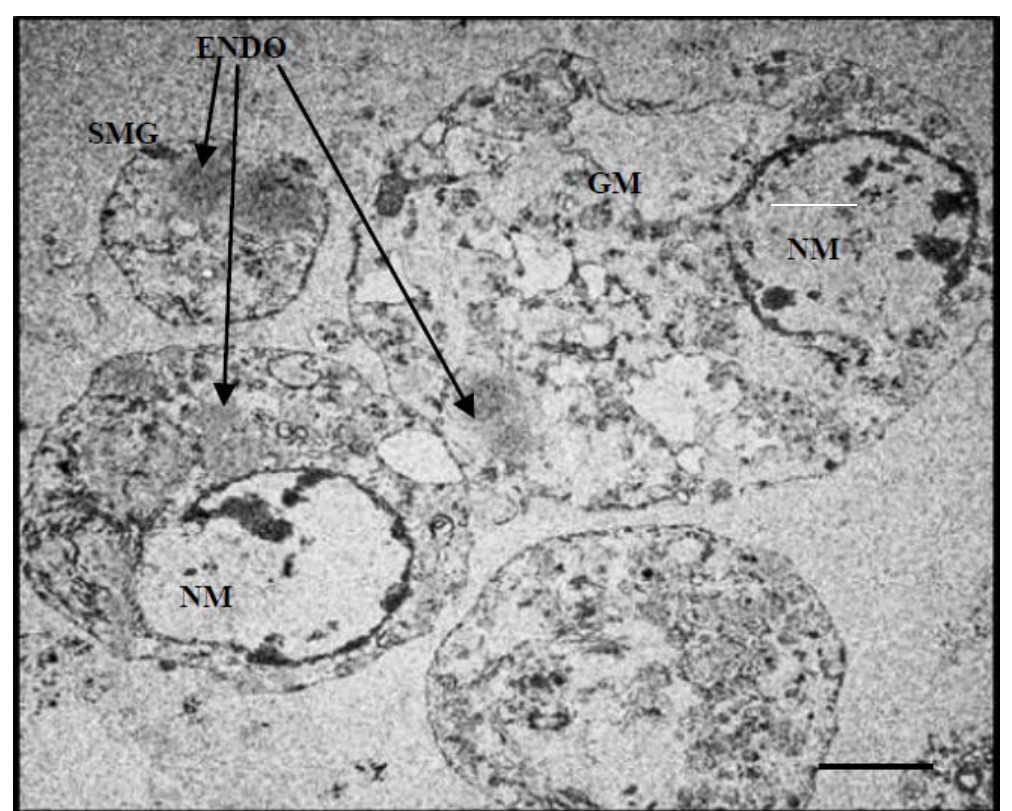
13 of 23 Figure 8. Tick cell growth and aggregation with gelatinous beads . ( a ) Light micrograph of gelatinous microcarrier bead (Cultispher ‐ G ® ) that reportedly has an irregular outer surface with flow ‐ through perforations providing external and in ‐ ternal cell binding locations, which was used to grow BmVIII ‐ SCC cells in rotating cell culture system bioreactor; Scale bar = 12.5 μ m. ( b ) Lateral light microscopic view of multiple BmVIII ‐ SCC—gelatinous bead aggregates on day 85 p.i. Membrane ‐ bound and translucent large cell ‐ like structures appeared to bud from bead surfaces covered with cells (arrow). View: 400X. Scale bar = 25 μ m. Further ultrastructural analysis by TEM of BmVIII ‐ SCC cells in gelatinous gel aggre ‐ gates on day 85 p.i. revealed small granular and larger multivacuolated cell types sur ‐ rounded by uniform, granular electron translucent material (Figure 9). As observed by E ‐ SEM (Figure 6), neither defined fibrocyte cell morphology nor fibrous ‐ like covering could be distinguished in the TEM thin sections. However, individual cells appeared to be sur ‐ rounded by a granular ‐ like material. A cross ‐ sectional view of a four ‐ cell aggregate showed a small granular cell (Figure 9, SMG) and three larger multivacuolated granular cells that exhibited membrane ‐ bound vacuoles with electron ‐ translucent material. The cy ‐